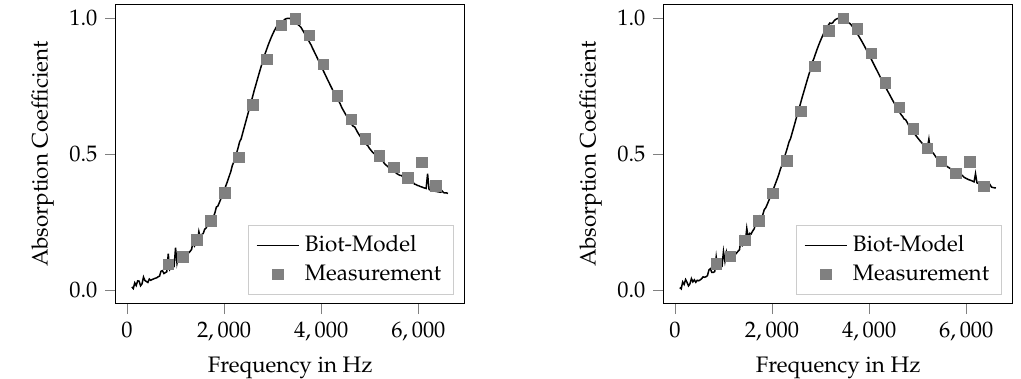
( a ) Measurement and FEM-result for Ref 1 specimen. ( b ) Measurement and FEM-result for Ref 2 specimen. Figure 4. Measured and computed absorption characteristics after inverse parameter identification Ref 1/2